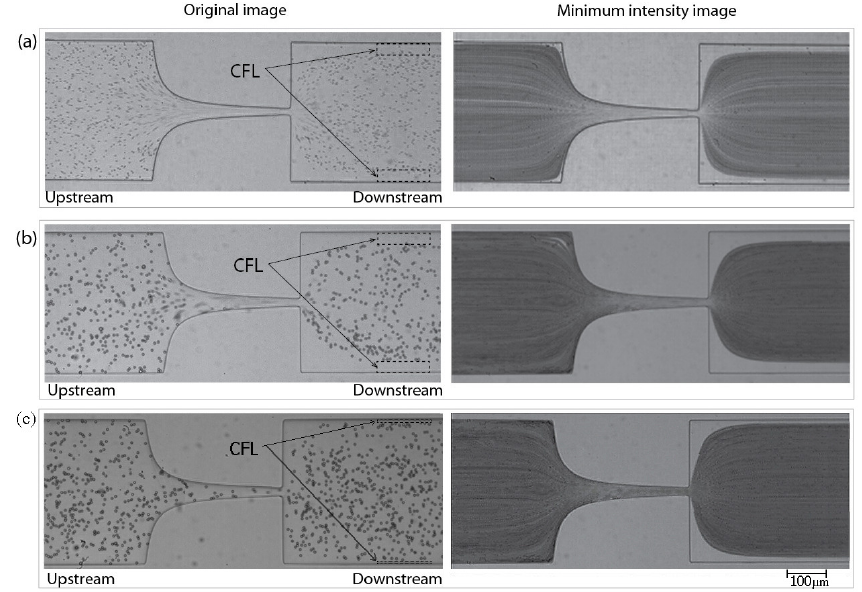
Figure 5. Images of ( a ) Red Blood Cells (RBCs) flow, B1 , ( b ) two-phase viscoelastic solution flow, X2 and ( c ) PMMA particles in Dx40 flow, D2 . Left : an original image; Right : a minimum intensity